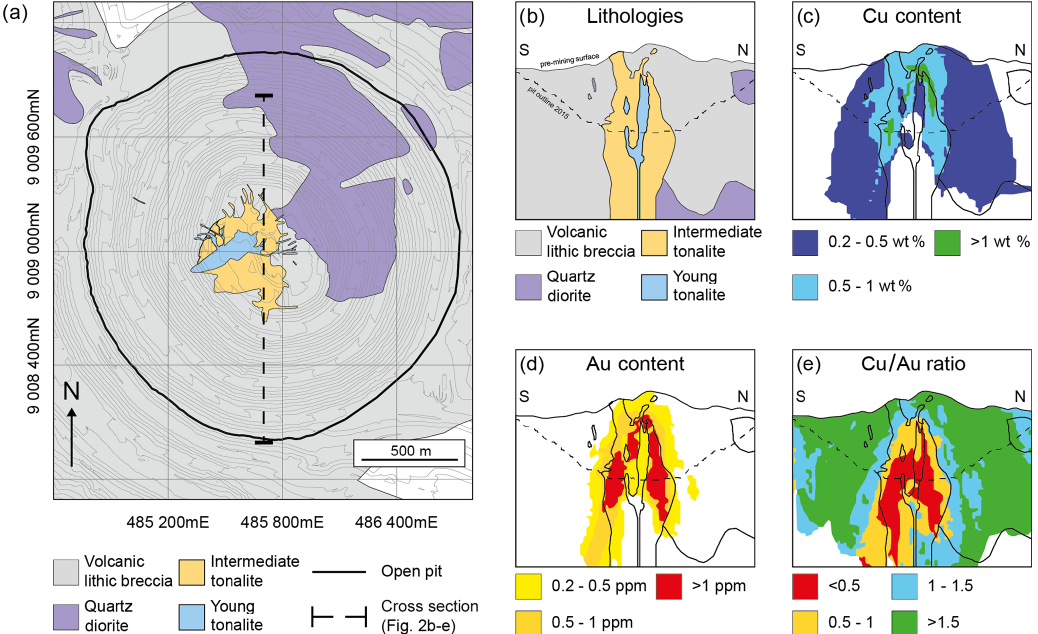
Figure 2. Geological map (a) and north-to-south cross-sections with lithological information and grade contours (b–e) of the open pit at Batu Hijau. The intermediate and young tonalite intruded into a volcanic lithic breccia and the equigranular quartz diorite (a, b) . Note that the extent of the old tonalite is not displayed but is included in the intermediate tonalite. The dashed line in panel (a) is the N–S section displayed in (b) – (e) . Thin grey lines in panel (a) indicate mine benches. Cu and Au grades (c, d) are enveloped around the tonalites and a deep, central barren core. High-grade Cu and Au mineralisation is cut by the young tonalite. The ratios of Cu to Au (e) illustrate strong Au enrichment proximal to the intermediate tonalite and Cu-dominated distal mineralisation. Map, section and grades are based on company information from May